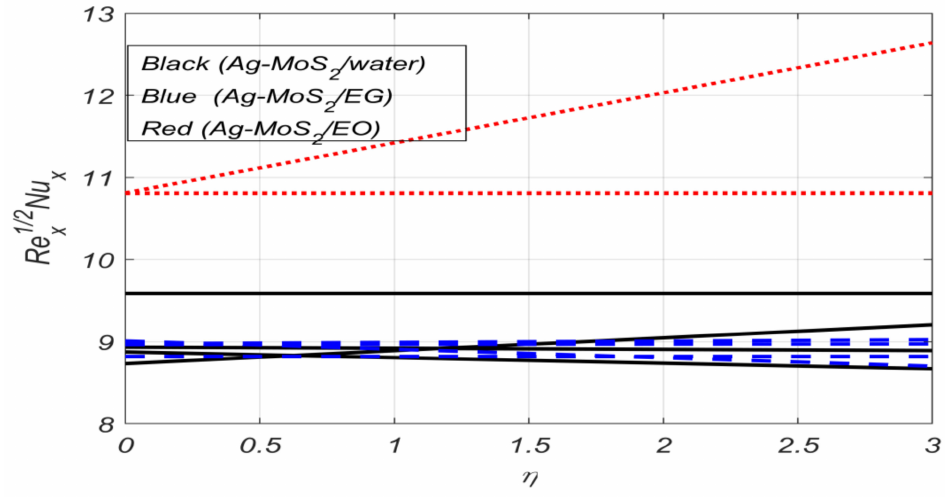
Figure 6. The behavior of the Nusselt number ( Nu x ) for the three